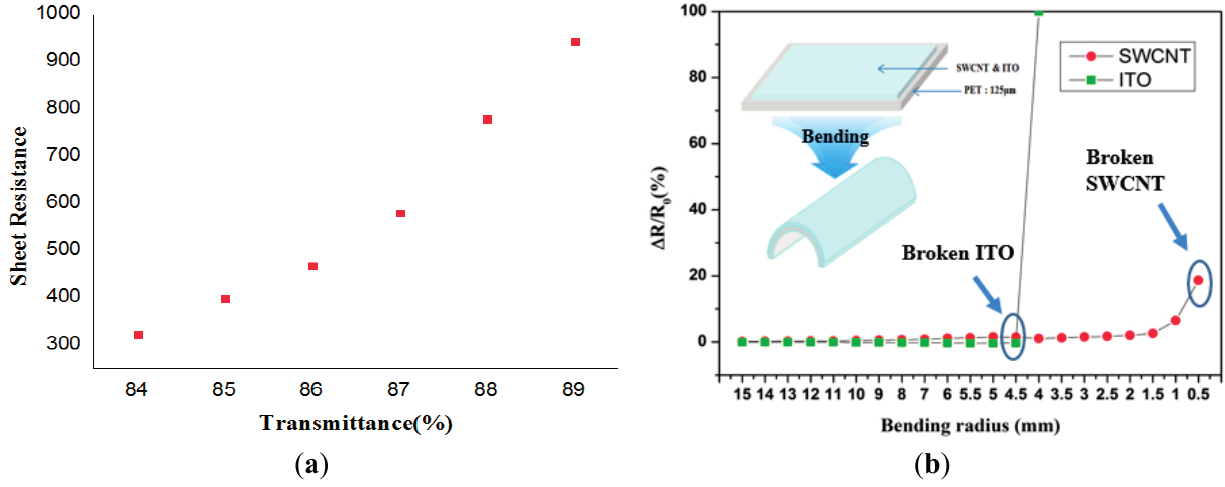
Figure 1. The sheet resistance graph for a 125 um thick PET film showing the transmittance and measured resistance change of an SWCNT electrode according to bending radius; The SWCNT electrode maintains a fairly stable resistance up to a bending radius of about 3 mm. ( a ) The measured sheet resistance and transmittance of coated SWCNTs; ( b ) The measured resistance change of SWCNTs and ITO electrode on the PET film according to bending